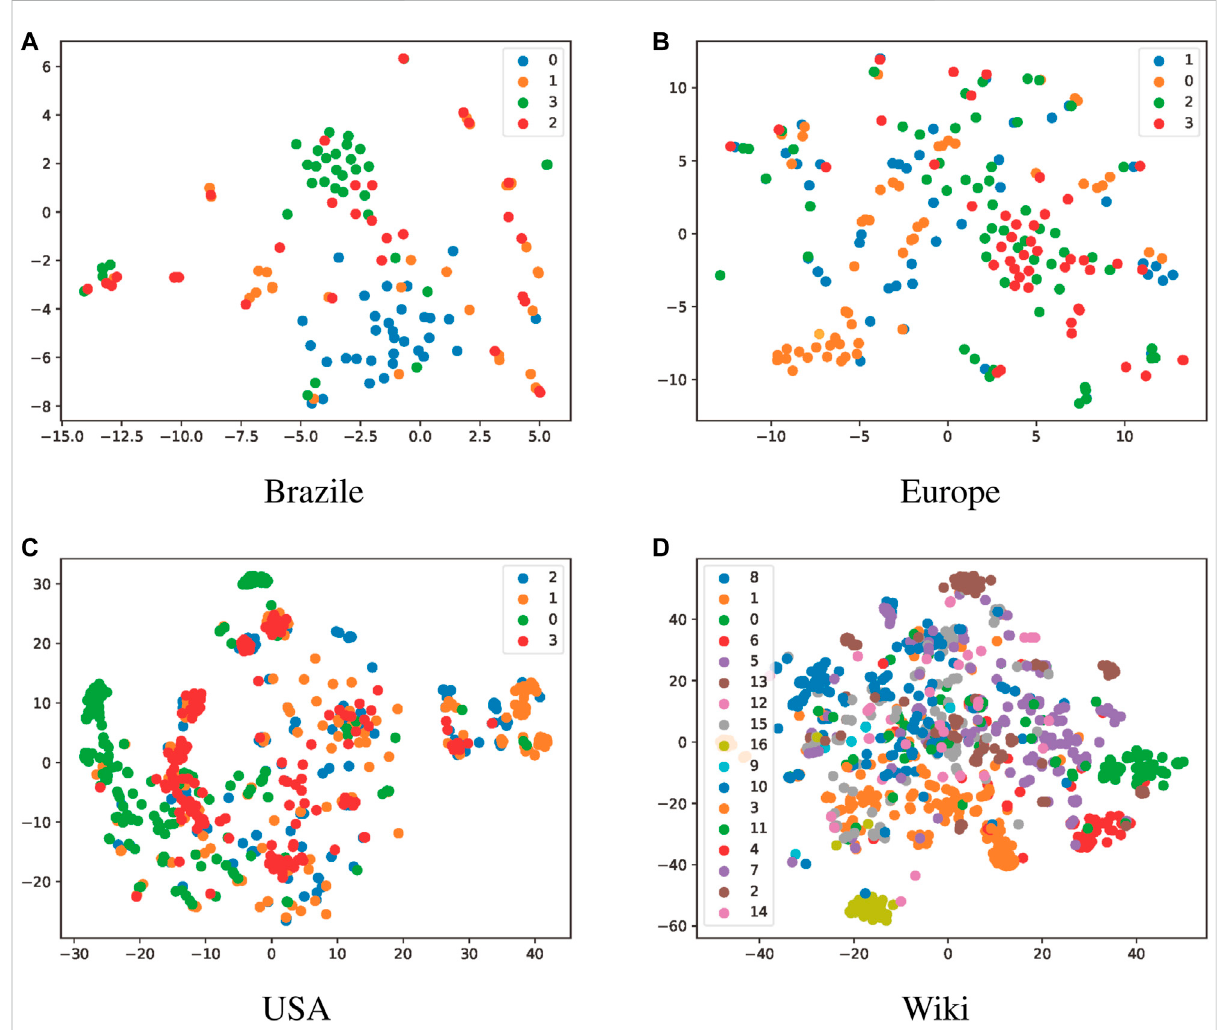
FIGURE 2 Theresultsofnodeclustering.Thedifferently coloredpointsrepresentdatawithdifferentlabels,andthelabelnumberisthecategorynamesof the